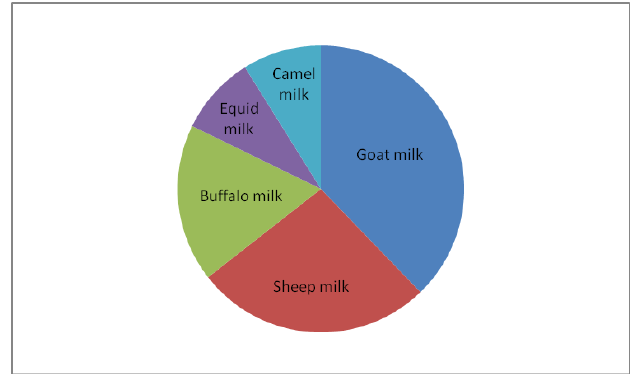
Figure 2. Research on non-cow milk and ALP from the last 20 years.